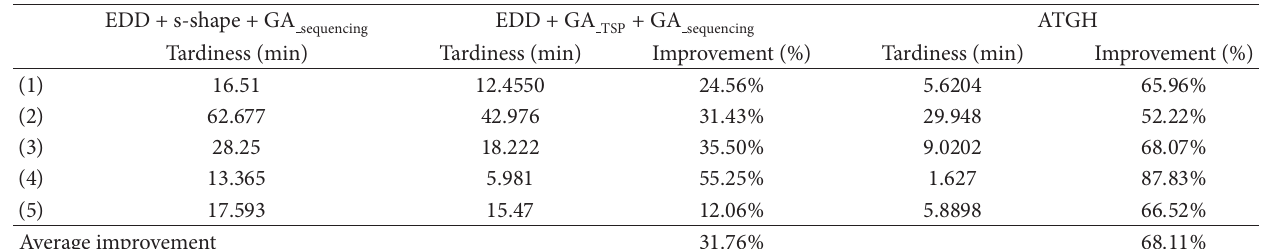
Table 10: Comparison